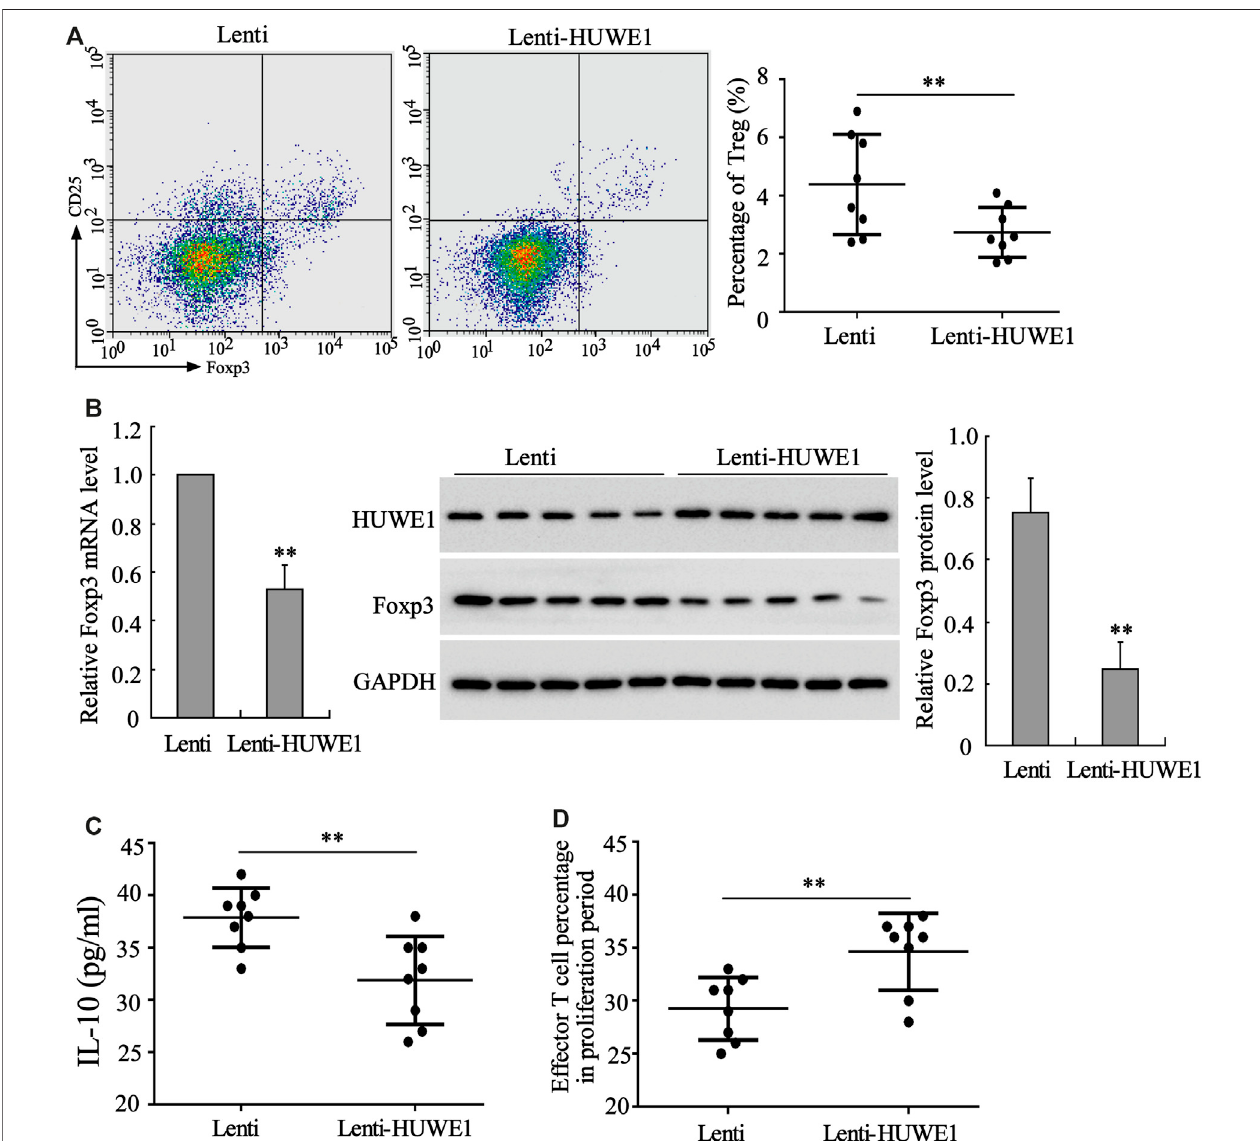
FIGURE3| EffectofHUWE1overexpressiononTregcellpercentage,Foxp3expression,IL-10productionandTregcellimmunosuppressivefunction.CD4 + Tcells in peripheral blood from healthy controlsweretransfectedwith Lenti-HUWE1 for 96 h. (A) Flowcytometry wasperformed todetect the percentage ofTreg cellsin CD4 + T cells(mean ± SEM, n (cid:2) 8). (B) qRT-PCR wasconducted tomeasure the mRNAlevelof Foxp3 inCD4 + Tcells and Western blot wascarried out tomeasure the protein levels of Foxp3 and HUWE1 in CD4 + T cells; and the quantitative analysis of Foxp3 protein level (mean ± SEM, n (cid:2) 5). (C) ELISA was applied to detect the concentration ofIL-10in theCD4 + T cellculture supernatant(mean ± SEM, n (cid:2) 8). (D) An immunosuppression experiment wasconducted to assess theinhibitory effect of Treg cells on the proliferation of effector T cells (mean ± SEM, n (cid:2) 8). ** p < 0.01 vs. Lenti. The experiment was repeated three times. Figure 2C . Besides, the interference with HUWE1 increased the enhanced the inhibitory effect of Treg cells on the IL-10 concentration in the CD4 + T cell culture supernatant proliferation of effector T cells. ( Figure 2D ). Furthermore, the immunosuppression assay clari fi ed that the HUWE1 knockdown accelerated the inhibitory effect of Treg cells on the proliferation of effector T cells ( Figure 2E ). Meanwhile, CD4 + T cells in peripheral blood from ITP patients transfected with HUWE1 shRNA elevated the CTLA-4 and LAG3 expressions ( Supplementary Figure S1A ). In conclusion, the HUWE1 knockdown elevated Treg cell percentage, Foxp3 expression and IL-10 production and